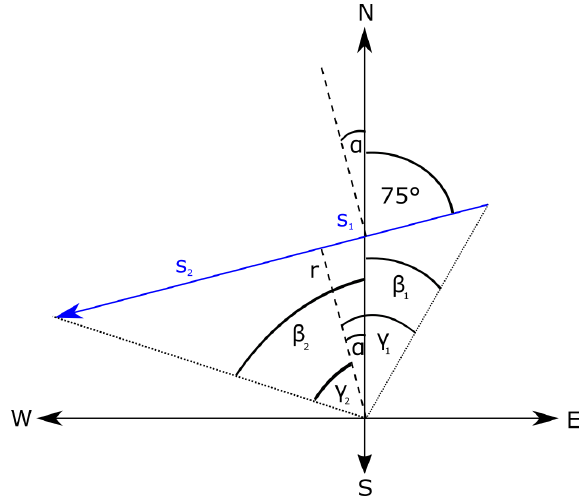
Figure 10. NO 2 DSCDs in 4 ◦ elevation angle (binned every 30min) on 20 September 2016. A transport event occurred between 10:00 and 11:00UTC.